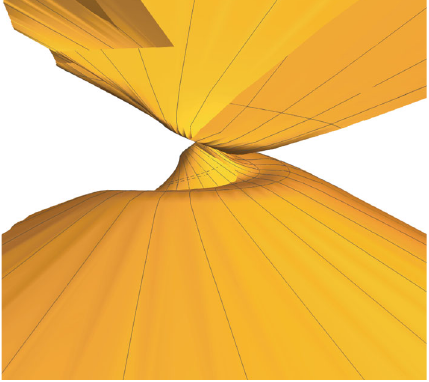
Figure 2: Harmonic surface Γ